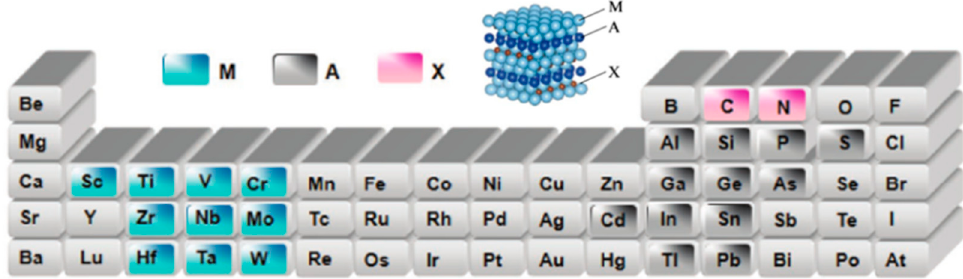
Figure 11. The possible constituent atoms of MAX in the element table. Reproduced from [66], with permission from Wiley, 2018. Stereogram of the 3D MAX phase. Reproduced from [70], with permission from Russian Academy of Sciences and Turpion Ltd., 2013.